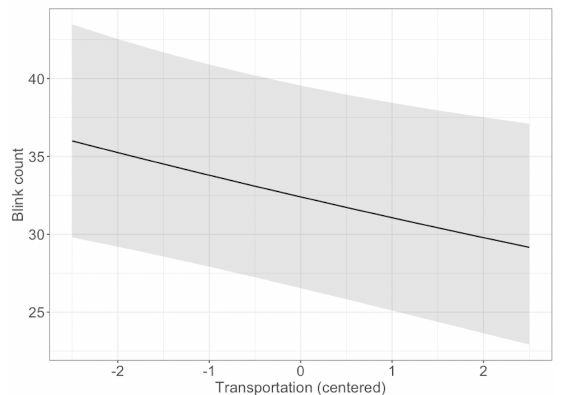
Figure 7. Model estimates for blink count. The shaded area represents 95% confidence